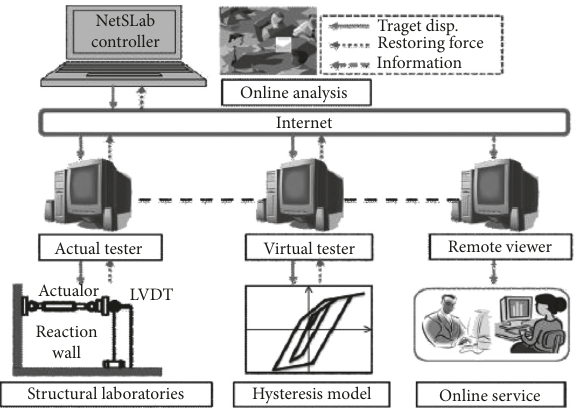
Figure 8: Primary module and interface of